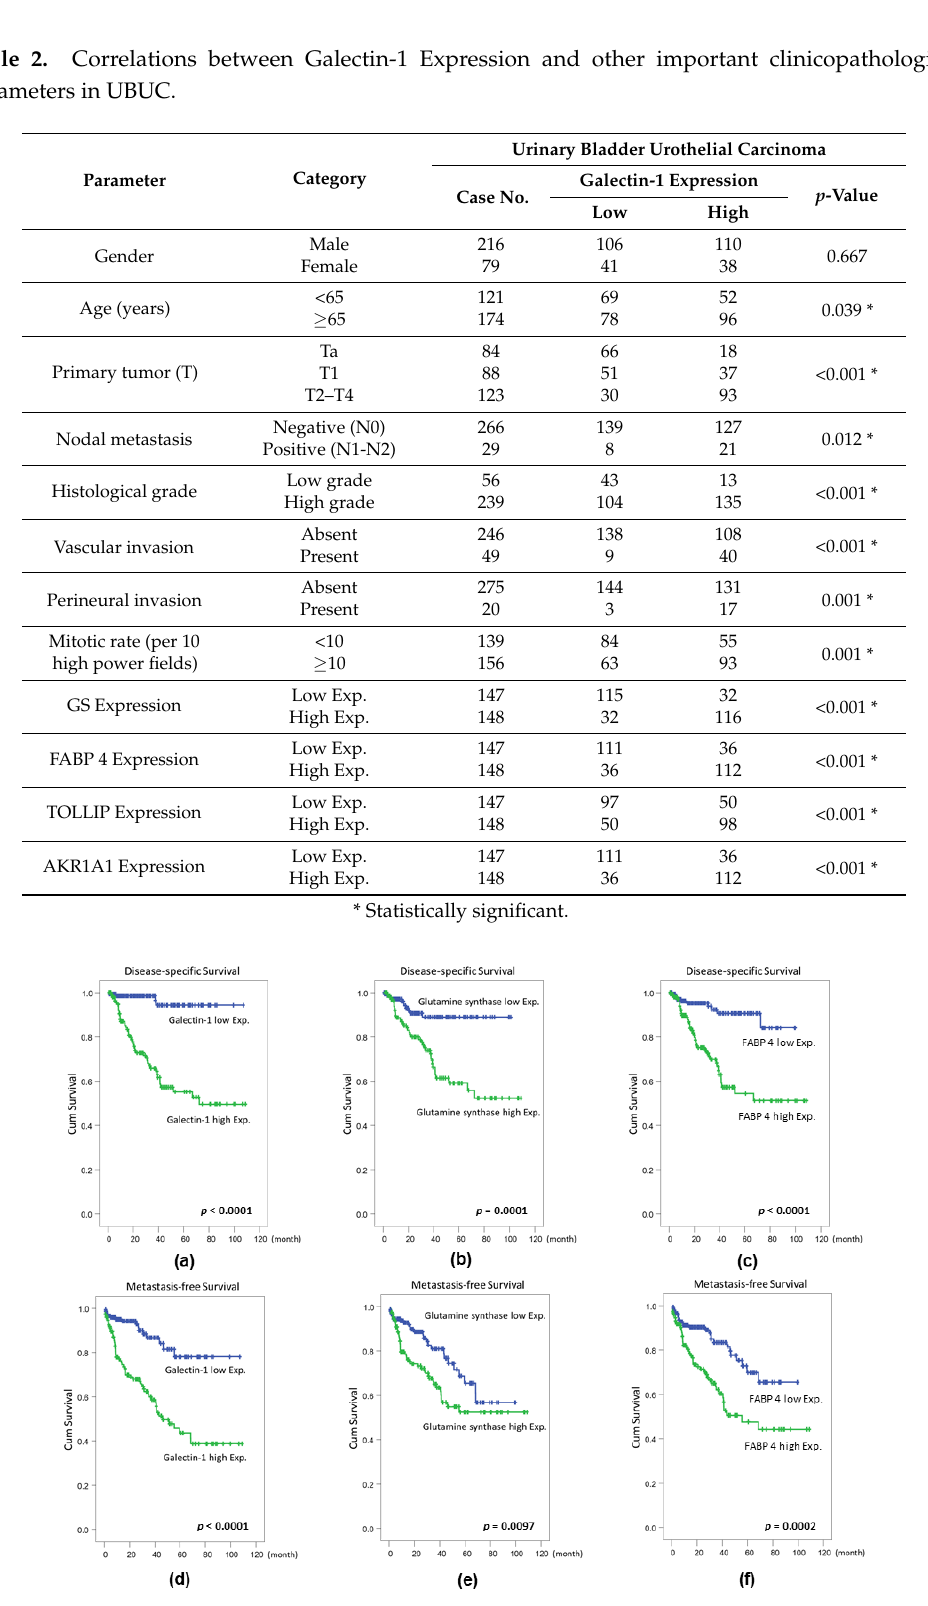
Figure 3. Survival analyses by log-rank tests. Disease-specific survival (DSS) and metastasis-free survival (MFS) of patients with urinary bladder urothelial carcinoma (UBUC) were significantly associated with ( a , d ) galectin-1 over-expression, ( b , e ) GS over-expression, ( c , f), and FABP 4 over-expression.